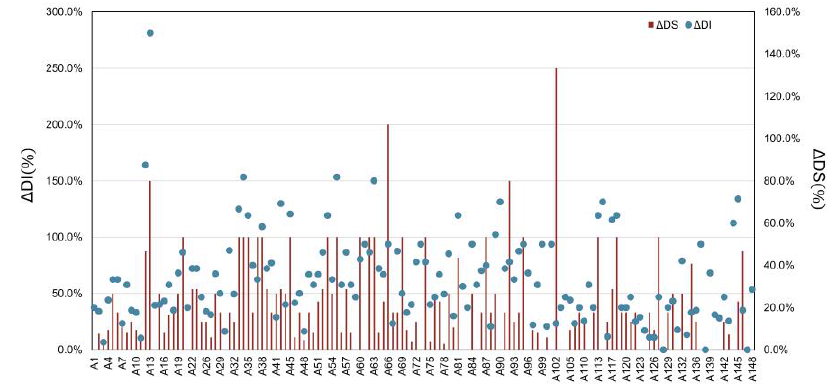
Figure 8. (bottom) ∆DS and ∆DI between 2018 and 2019. The X-axis indicates the vineyards sampled, which were labeled from A1 to A148. Due to lack of space, not all labels are shown.